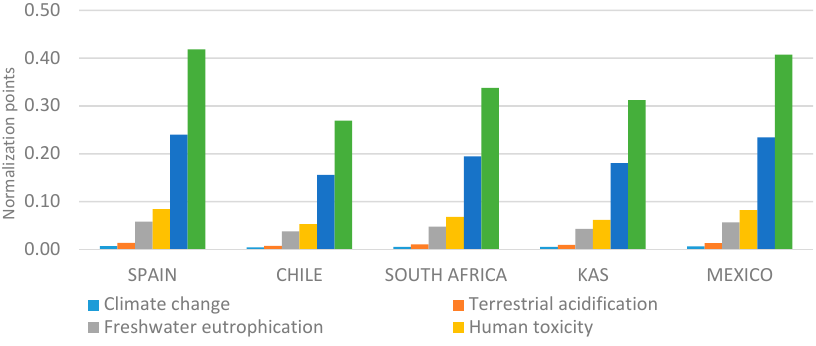
Figure 5. Normalization profile of the life cycle of a HYSOL plant located in different countries (Spain, Chile, KSA, and Mexico).